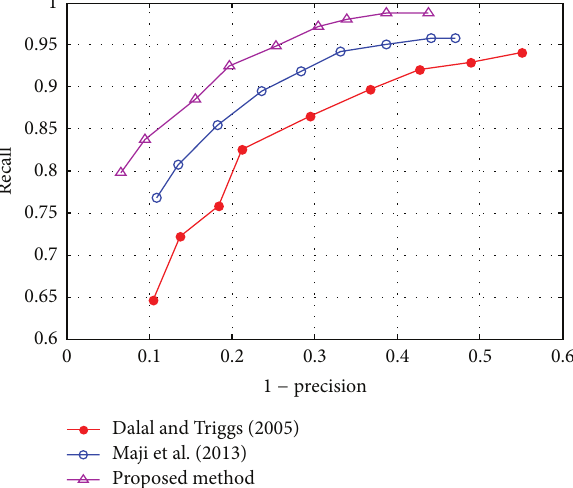
Figure 7: Performance of the three